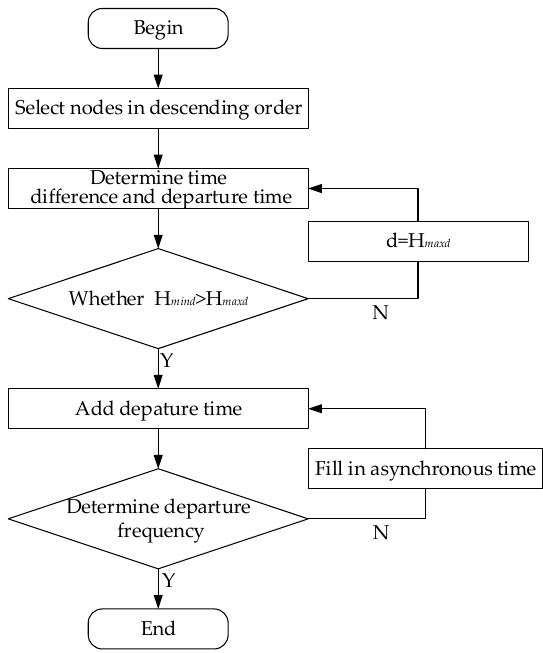
Figure 2. The flowchart of the intelligent optimization algorithm.